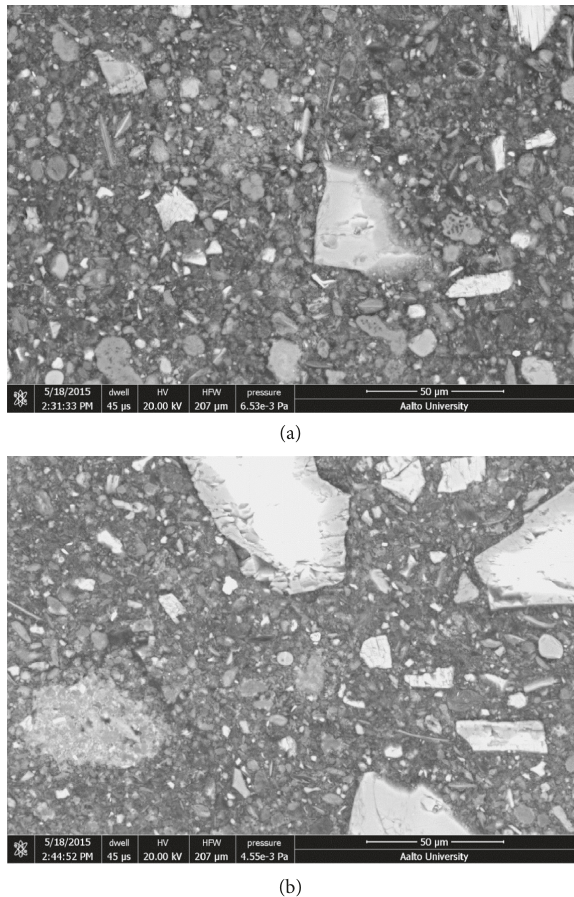
Figure 10: BSE-SEM images of 28-day old mixes: (a) MSiMgO and (b)